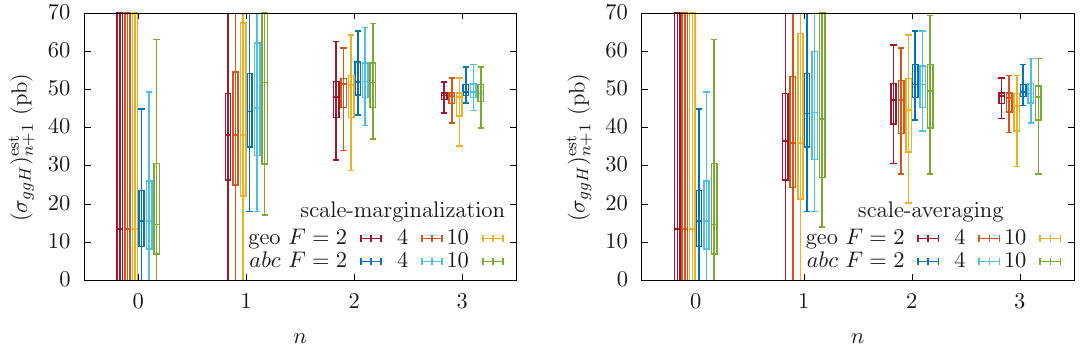
Figure 14 . Left: the dependence of the CIs on the size F of the scale interval ( µ 0 /F ≤ µ ≤ Fµ 0 ) for gluon-fusion Higgs cross-section for the geometric and abc -models using the sm-prescription Right: the same plot using the